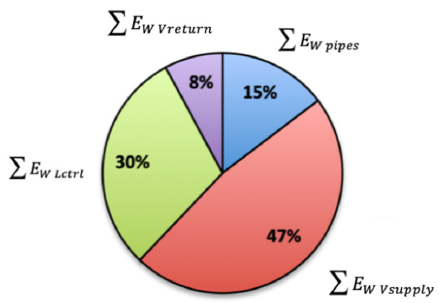
Figure 8. Distribution of the hydraulic system losses.